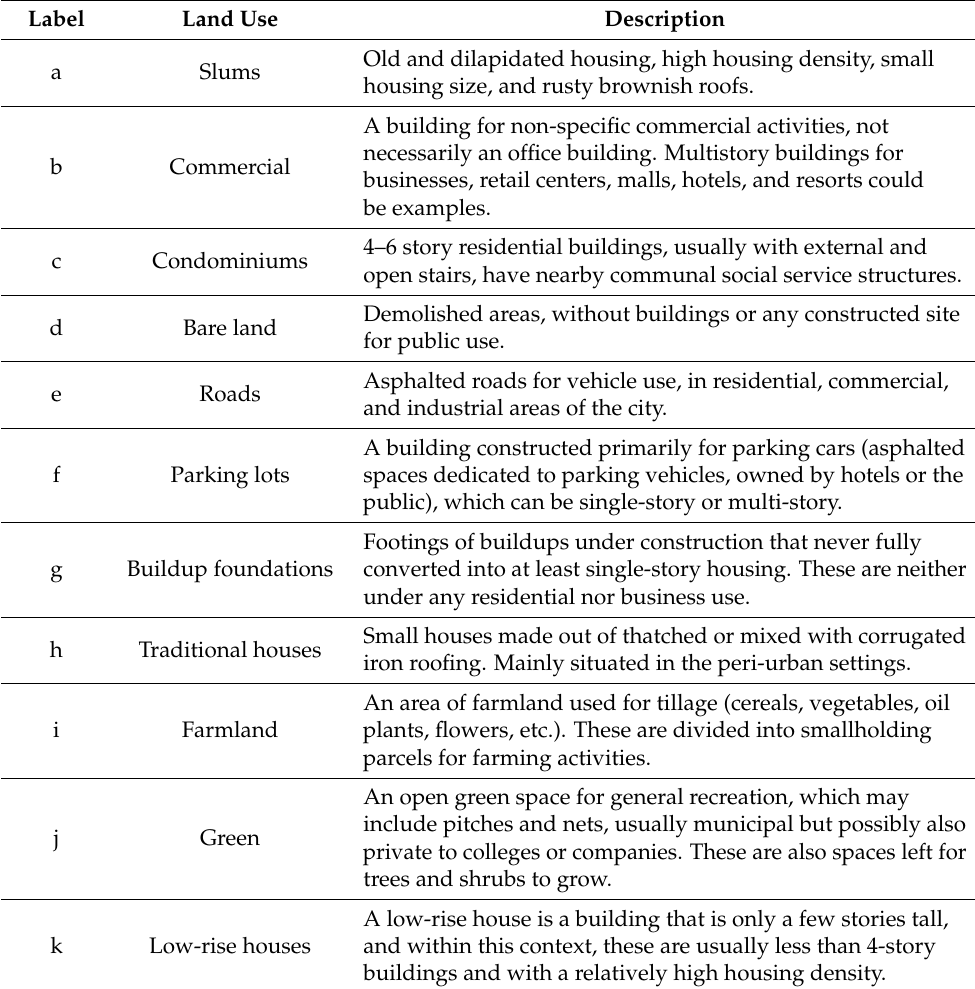
Table 1. The urban land use classification